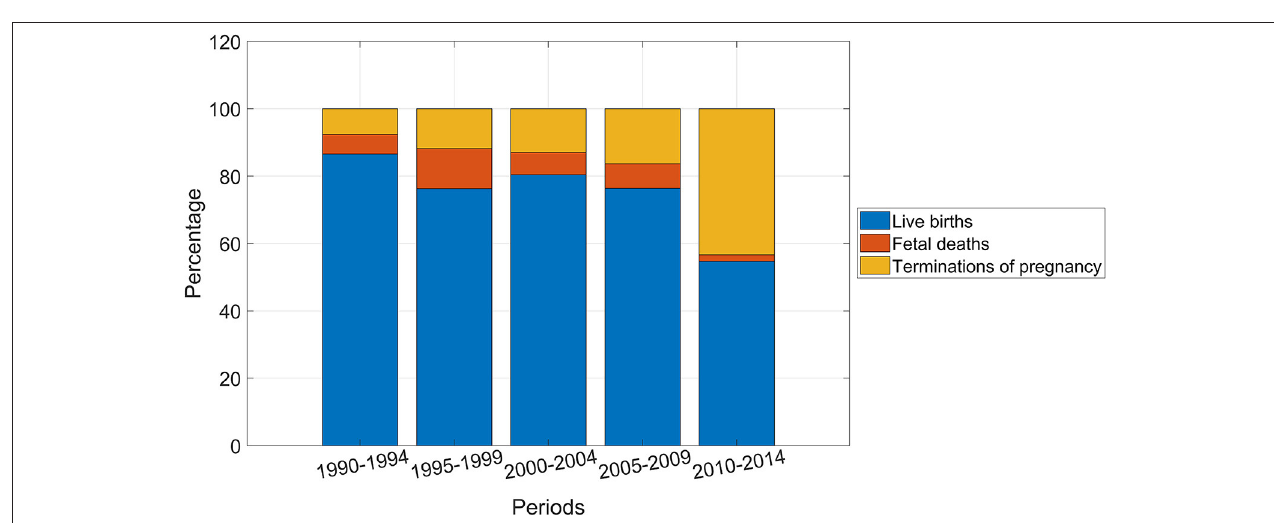
FIGURE 2 | Distribution of pregnancy outcome for fetuses and infants with multiple congenital anomalies, Funen, Denmark, 5 year periods 1990–2014.